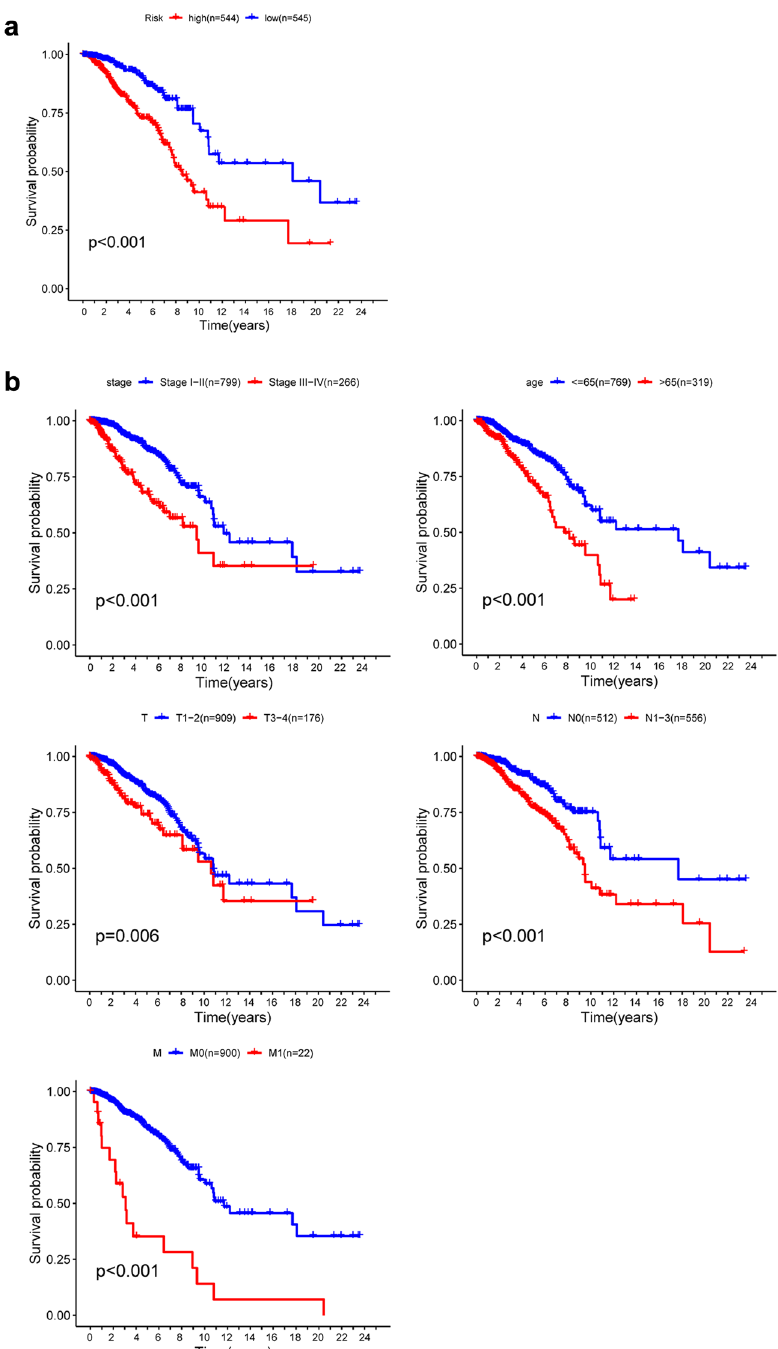
Figure 6. Kaplan–Meier survival study in TCGA data set for BC patients. ( a ) K–M survival curve for high/low risk BC patients. ( b ) Age, Stage, T-classification, N-classification and M-classification features involve patients survival in clinical